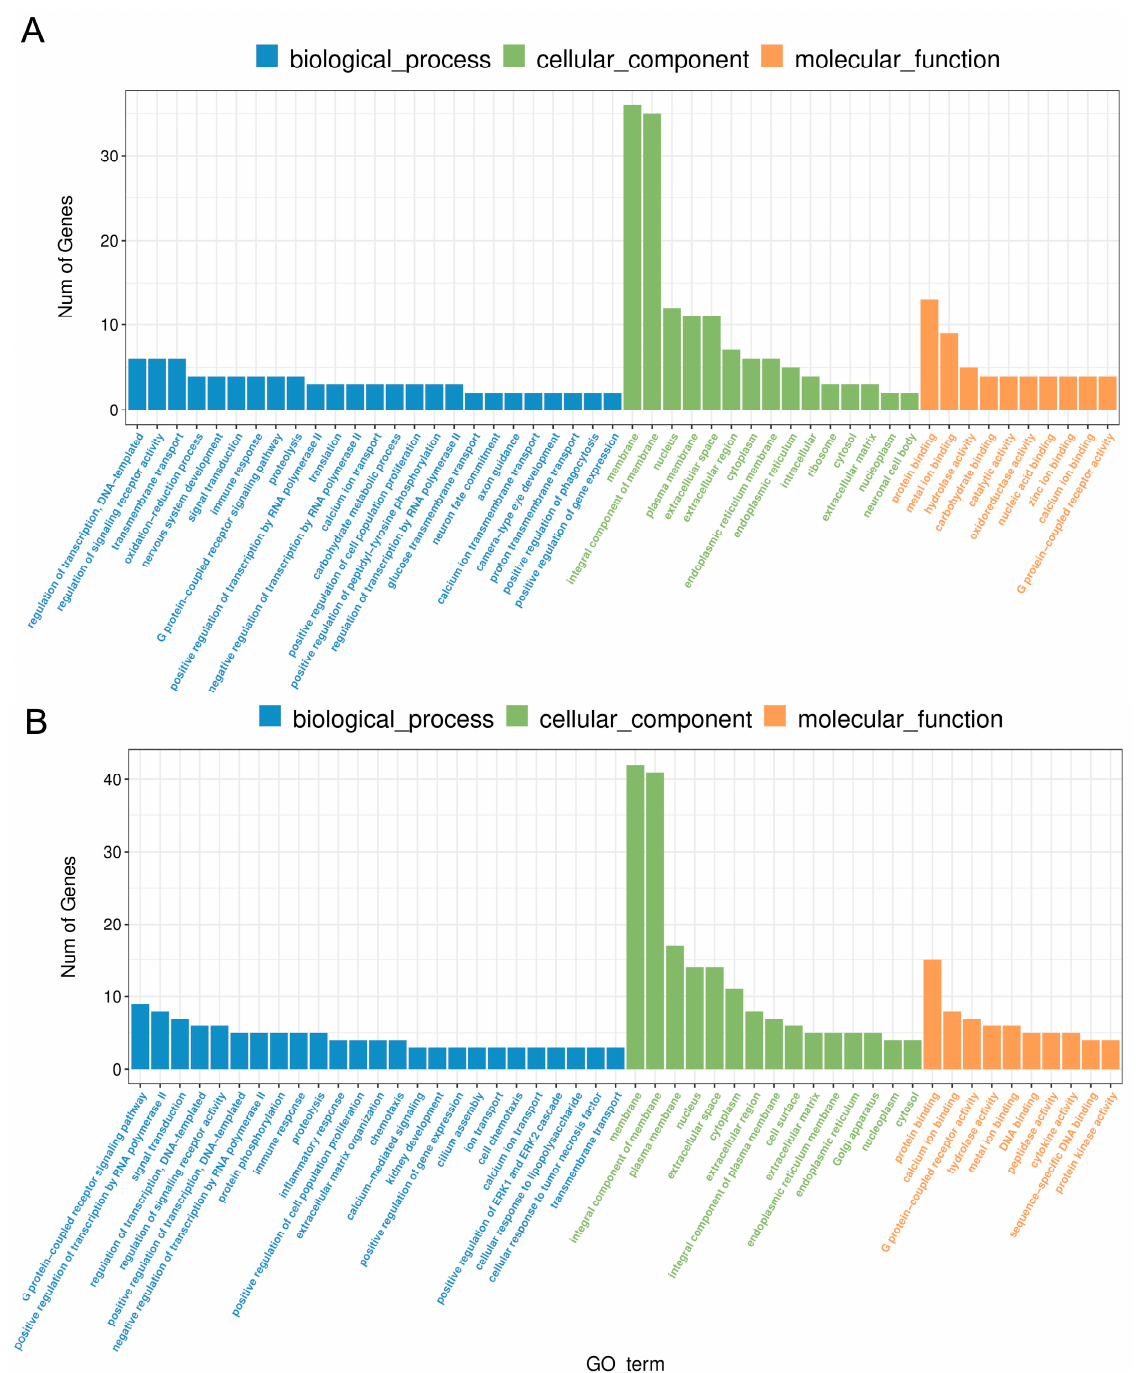
Figure 5. GO analysis of the differentially expressed genes after the treatment of the corpus luteum with GW0724 at a concentration of 10 μ mol/L (A) or GSK3787 ( B ) in the late-luteal phase of the estrous cycle. The x -axis indicates the terms of biological processes, while the y -axis indicates the number of significant enriched genes ( p < 0.05).